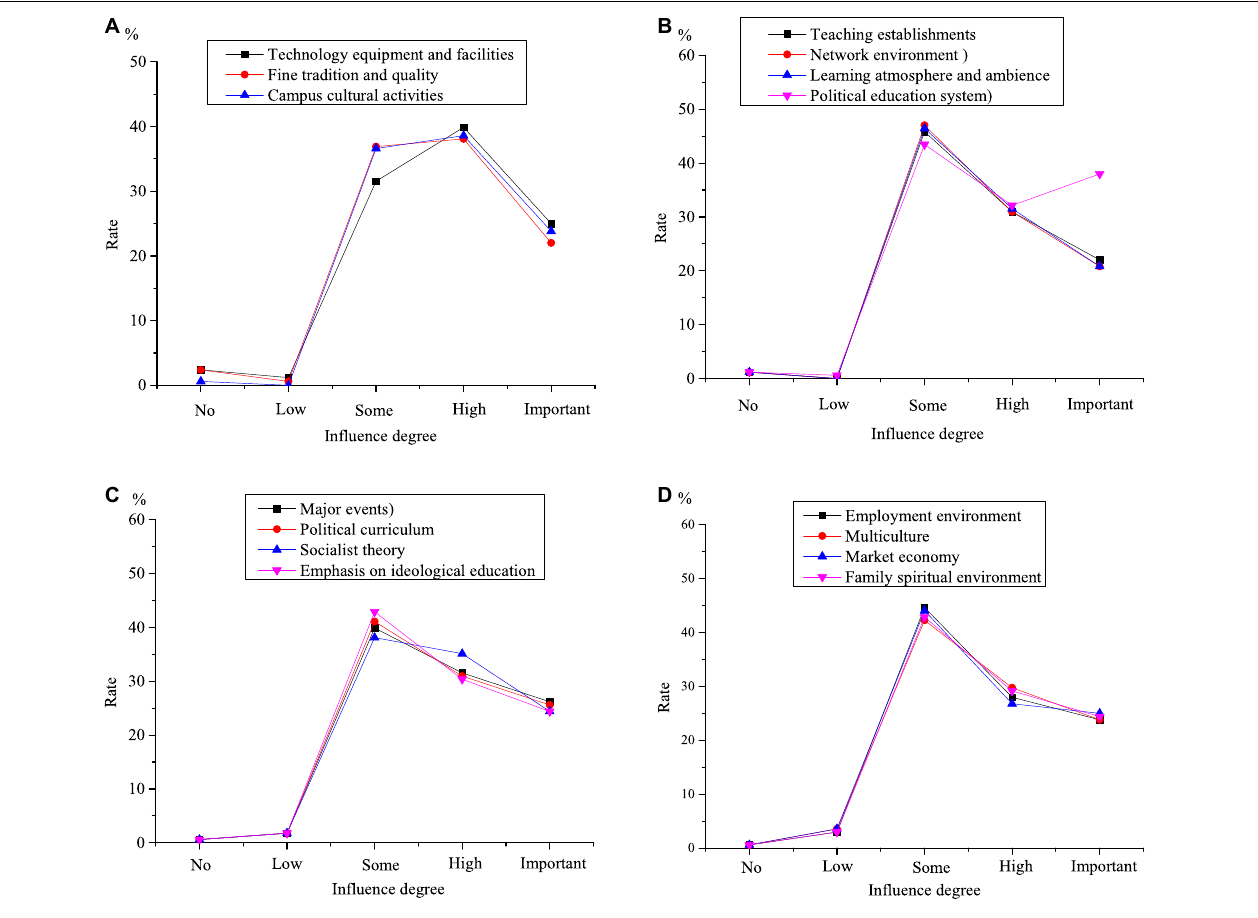
FIGURE 5 | Influencing factors (A) positive factors (B) negative factors (C) opportunities (D) challenges.